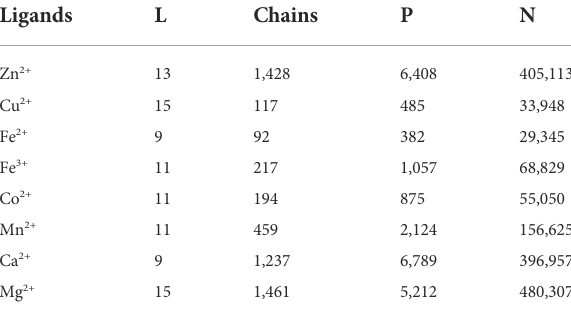
Note: Ligands represents metal ion ligand; L represents the sequence fragment length; Chains represents the number of chains in a protein; P represents the binding residues; N represents the non-binding